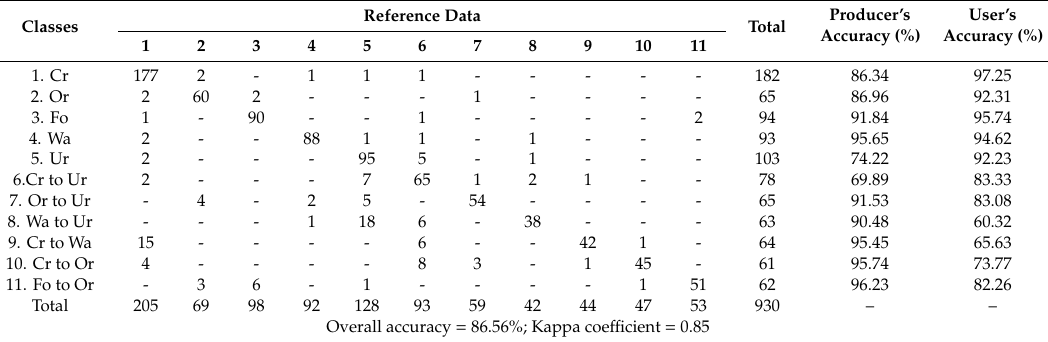
Table 10. Confusion matrix of the post-classification method,